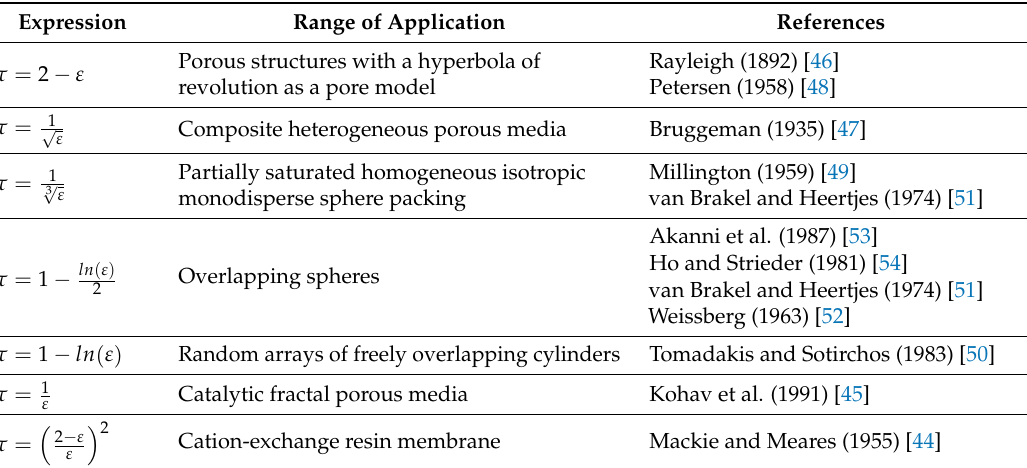
Figure 12. Overall comparison among the considered structures and several empirical expressions from the literature (see Table 3) [44–54]. The trends are shown in two plots for a better readability. Table 3. Empirical expressions of tortuosity vs.